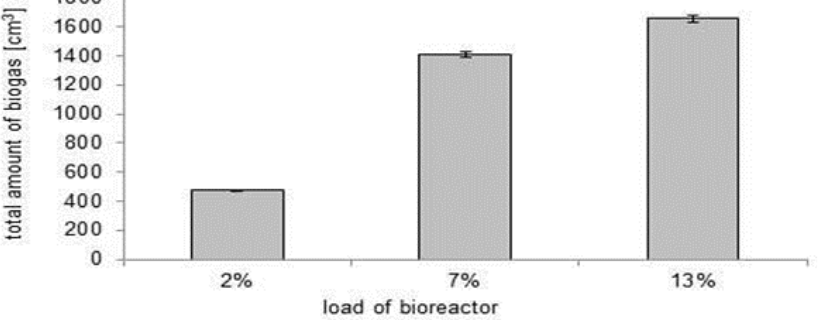
Figure 1. Total volume of biogas obtained during 3 week incubation for different values of bioreactor loading. Results from measurement series 1.